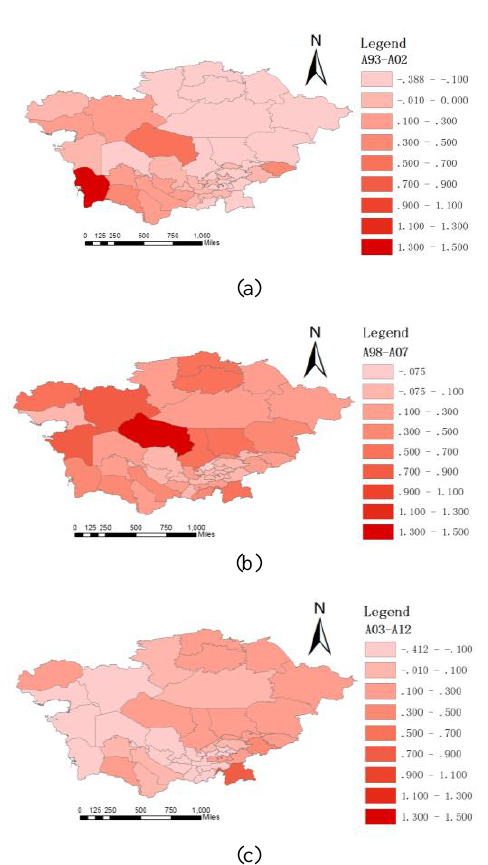
Figure 8. Change rate of night lighting (a)1993-1997; (b)1998- 2002; (c)2003-2007